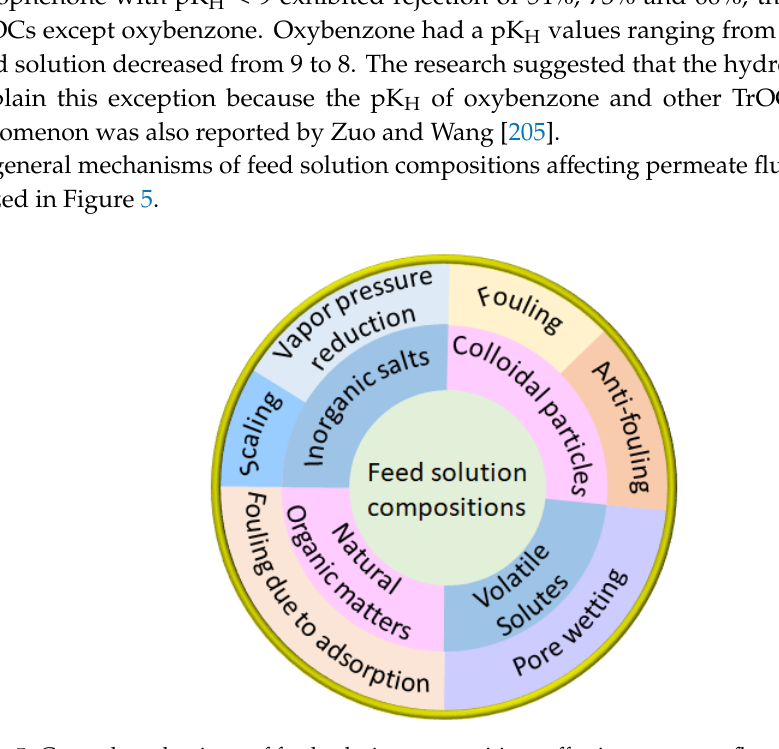
Figure 5. General mechanisms of feed solution compositions a ff ecting permeate flux and salt rejection in MD.